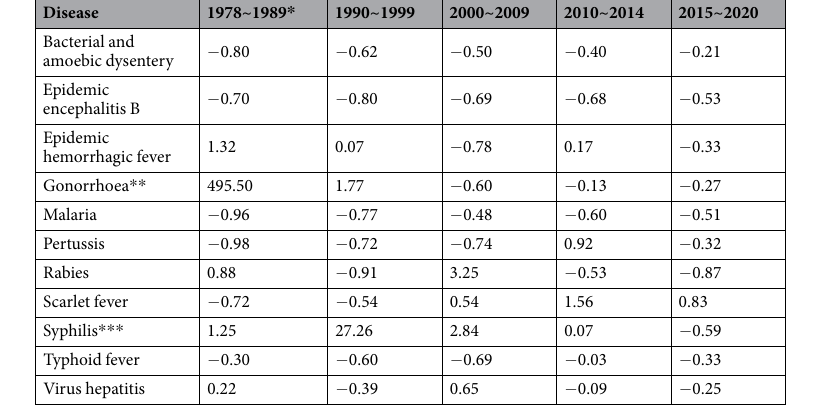
Table 4. The change rate for each disease from 1978 to 2020. * For each column, the change rate = (the incidence of the last year-the incidence of first year)/the incidence of first year. ** The first period for gonorrhoea was from 1981 to 1989. *** The first period for syphilis was from 1987 to The application of model.